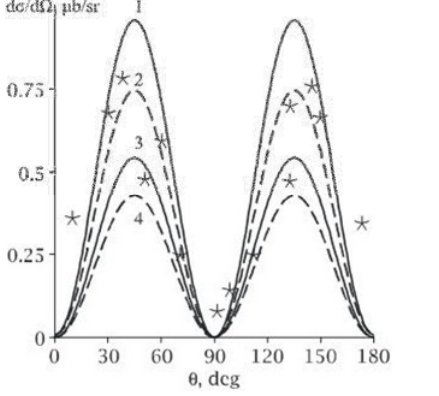
Figure 3. differential cross section (cid:1)(cid:2)(cid:4)(cid:5), (cid:7)(cid:8)(cid:7) n (cid:3) MeV, solid lines take into account a at o (cid:5) (cid:22) (cid:3)p contact part, dash lines don't take into account a contact part, curves 1, 2 were calculated using the Argonee parametrisation, curves 3, 4 were calculated using the Urbana parametrisation, * - experimental data